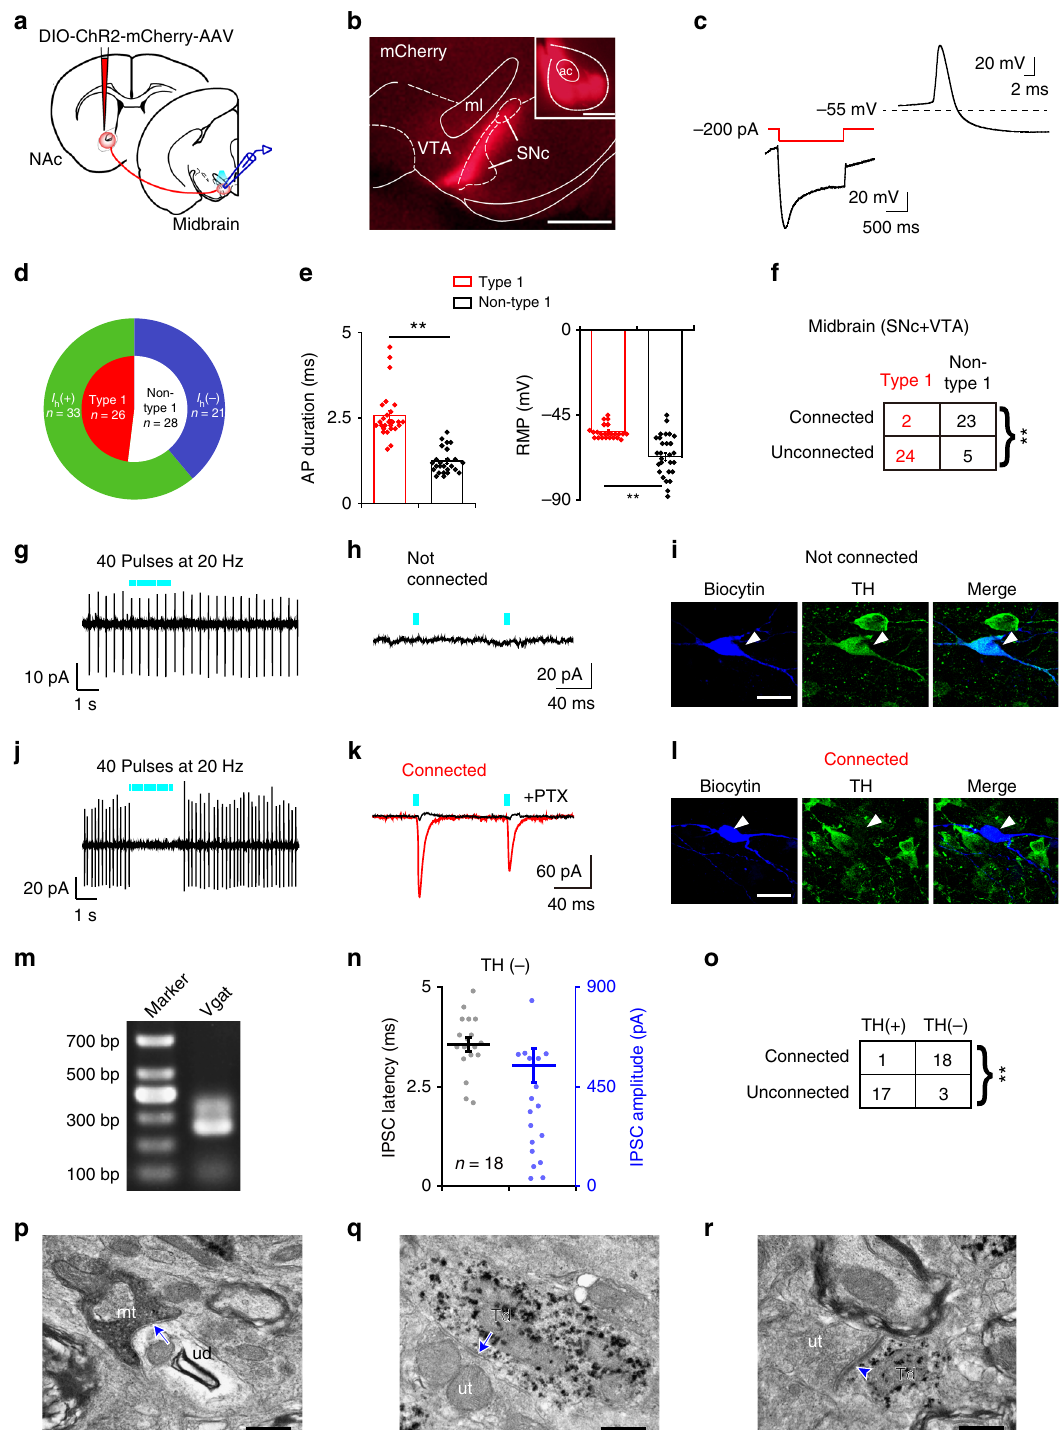
(Fig. 3b, c), indicating activation of ChR2-expressing D 1 R neurons by optogenetic stimulation. In addition, 20 Hz stimula- tion of the bilateral NAc produced immediate transitions from NREM sleep to wakefulness in ChR2-mCherry mice (5.7 ± 1.4 s; Fig. 3d, e, j and Supplementary Movie 1) but not in mCherry mice (80.2 ± 4.2 s; Fig. 3g, h, j and Supplementary Movie 2). In ChR2- mCherry mice, optogenetic stimulation induced immediate cortical activation, which was characterized by a signi fi cant decrease in slow-wave activity (a hallmark of sleep pressure)